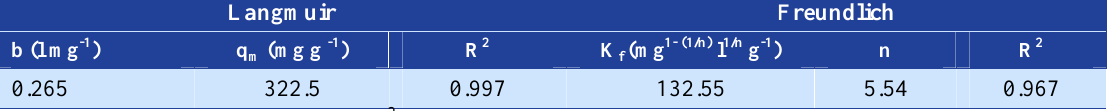
Figure 7. (a) Langmuir and (b) Freundlich isotherms for Co(II) ions adsorption onto NiFe nanoparticles O nanoparticles at 25 °C 2 4